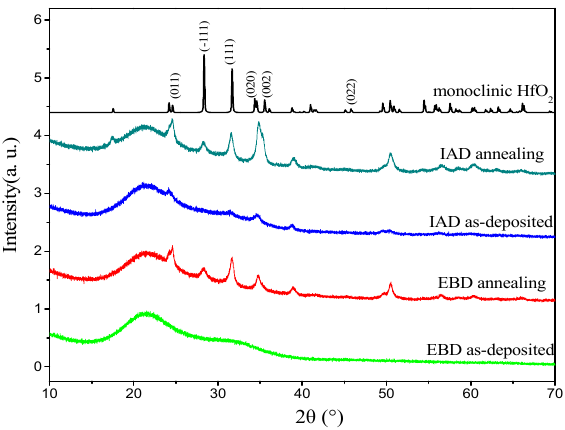
Figure 3. The XRD patterns of the prepared HfO 2 films.